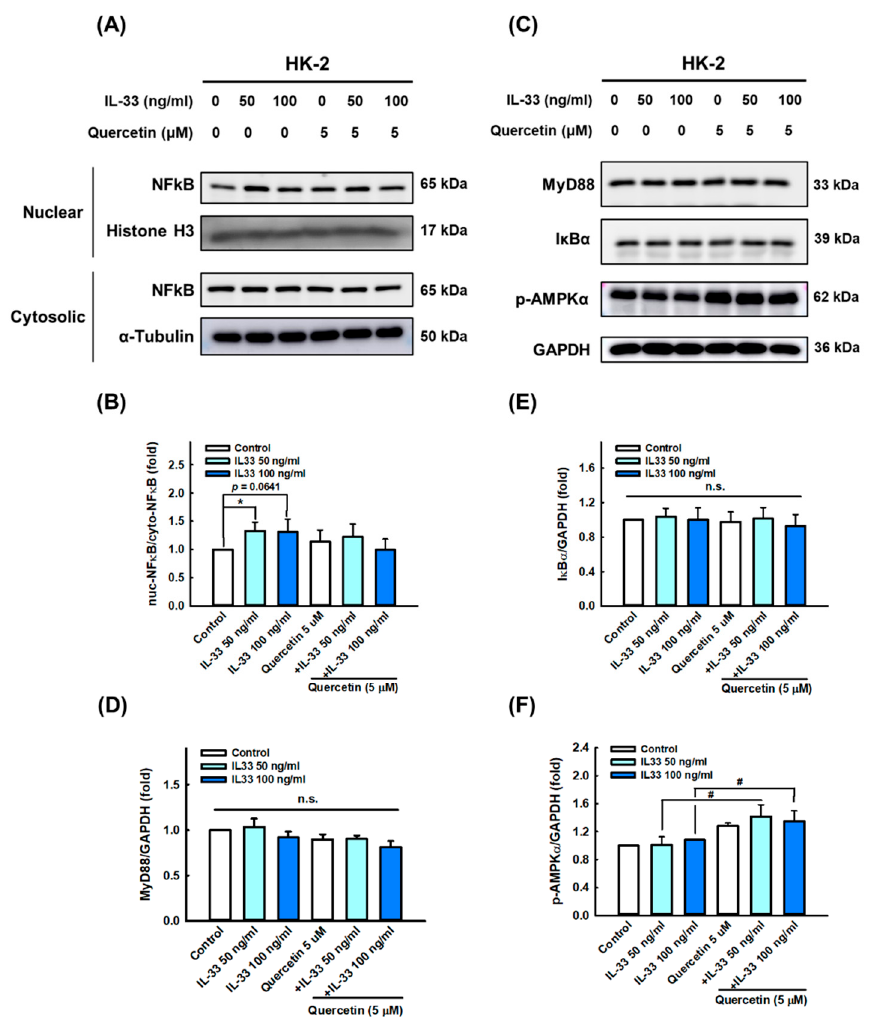
Figure 7. Quercetin regulated the expression of inflammation-related proteins in human renal tubular epithelial cell line. HK-2 cells were co-cultured with 5 µ M quercetin and 50 ng/mL or 100 ng/mL recombinant human IL-33 for 48 h. ( A – F ) Immunoblots and quantitative histograms showing the results of Western blotting analysis for the expression of NF- κ B, MyD88, I κ B α , and p-AMPK proteins. Data are expressed as mean ± SD ( n = 3). * p < 0.05 versus control group; # p < 0.05 versus corresponding IL-33-stimulated group; n.s. indicates not significant.